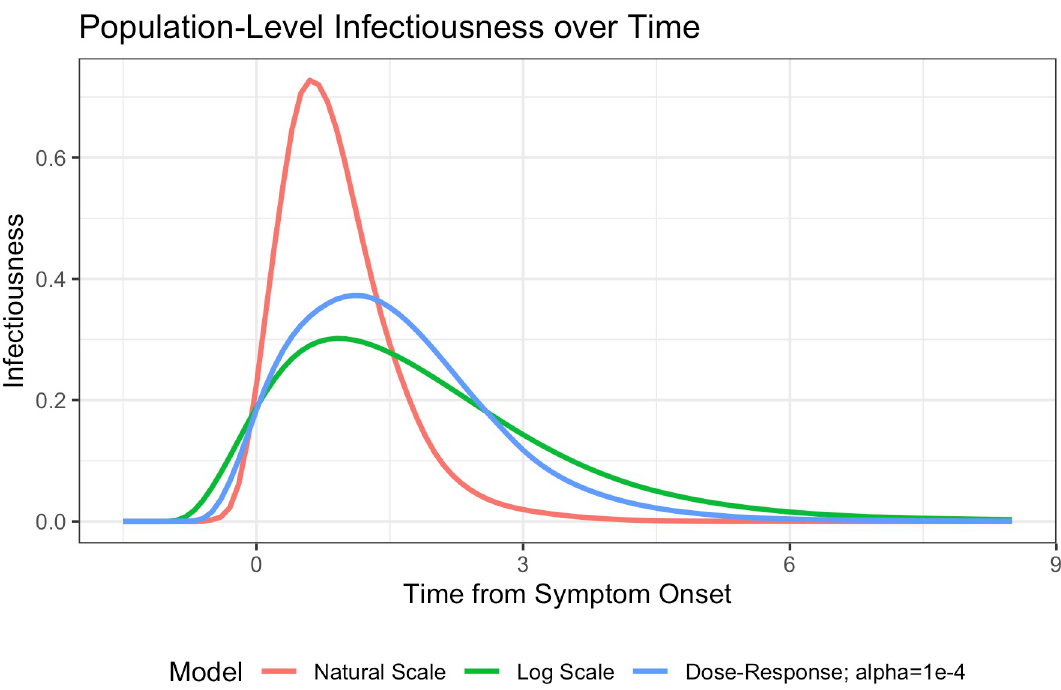
Fig 3. Estimated population-level influenza infectivity profiles over time from symptom onset according to the three epidemiological models studied. The probability densities are shown for the timing of secondary infections expected under each of the models considered. The VK model was used to simulate individual viral shedding trajectories and the epidemiological model was used to translate these into infectiousness profiles over time. These individual profiles were then normalized so that the area under the curve was equal to 1 (once averaged), with each individual contributing to the average proportional to their time-integrated total